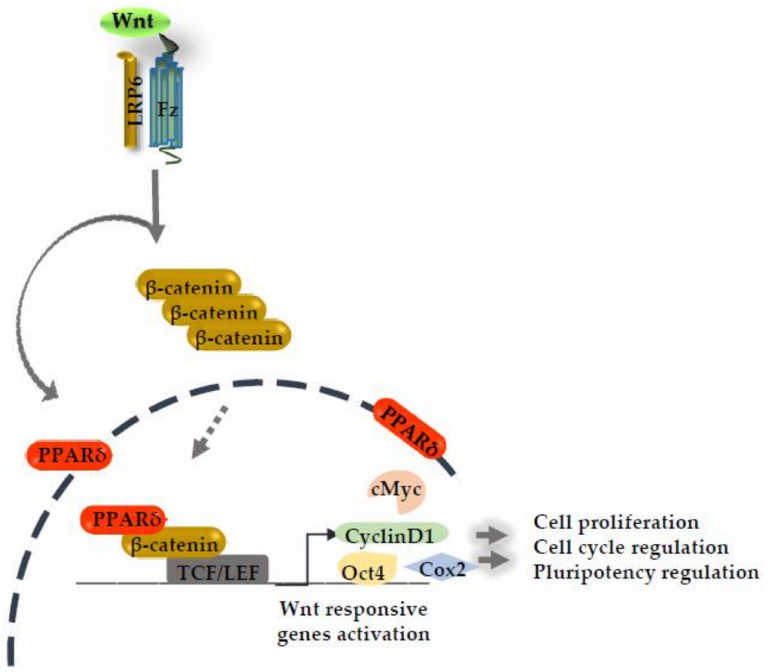
Figure 1. Canonical Wnt signaling activation induces the peroxisome proliferative activated receptor delta (PPAR δ ) expression. PPAR δ synergizes with the β -catenin transcriptional activation complex in the nucleus and boosts the expression of several Wnt responsive